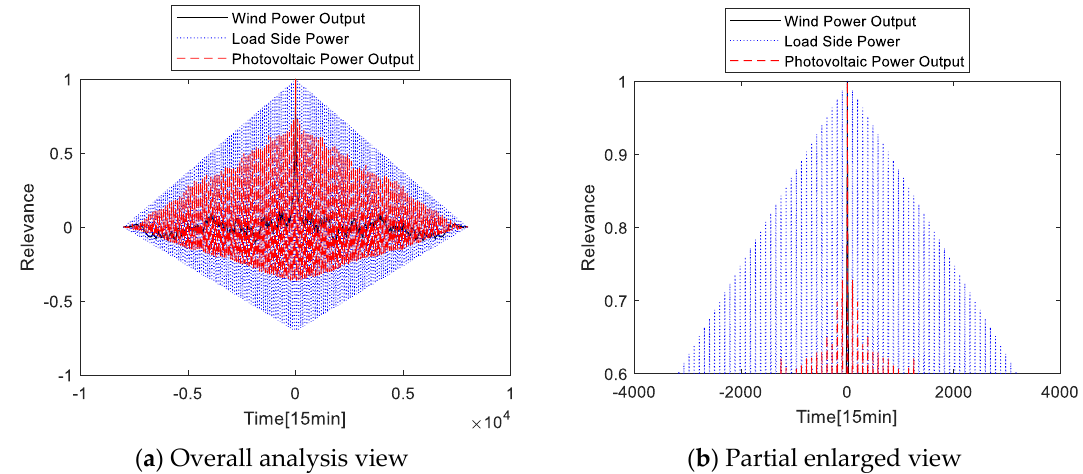
Figure 9. Autocorrelation analysis results of each object in the No. 1 power system.